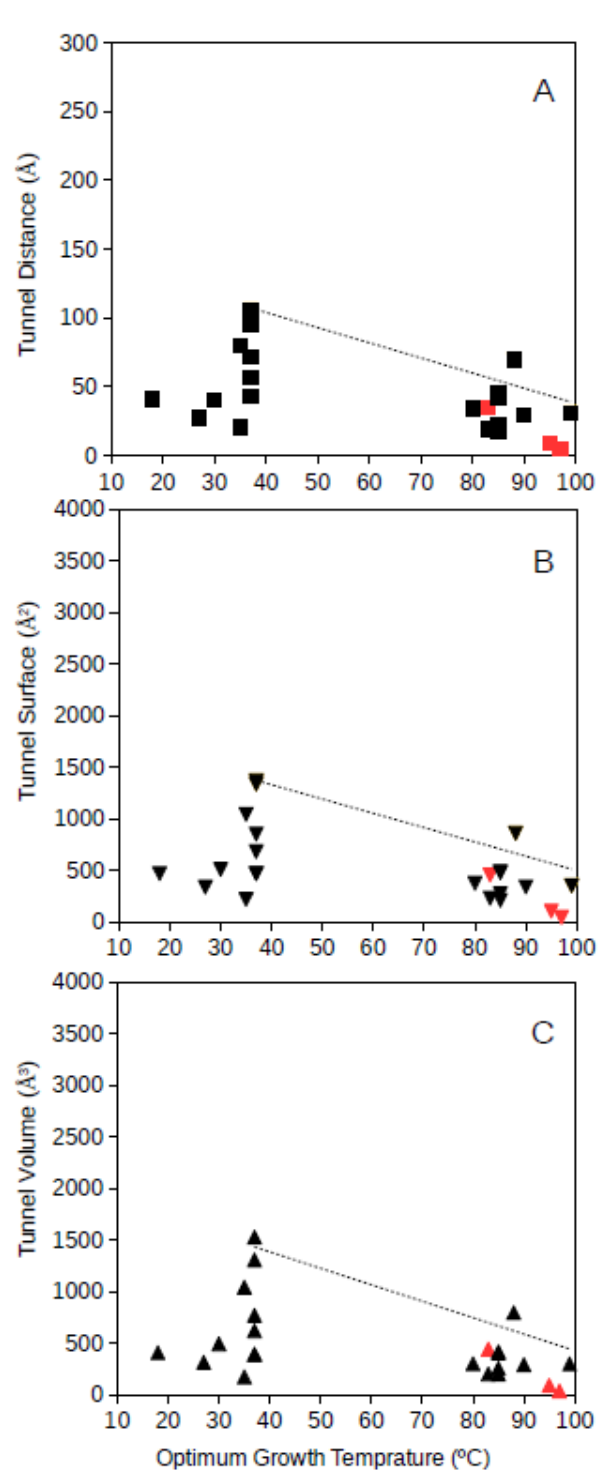
Figure 2. Tunnel distance ( A ), surface ( B ) and volume ( C ) (in Å) dimensions predicted for archaea GDHs ranging in optimum growth temperature from 15 ◦ C to 99 ◦ C. Grey line represents a visualization of the upper limit for these dimensions at increasing temperatures. Black symbols correspond to predicted protein structures; red symbols correspond to resolved model structures from the Protein Data Bank.